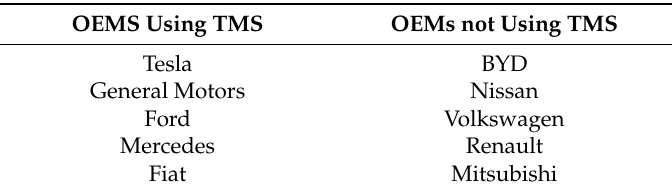
Table 6. List distinguishing OEMs who prefer to use a conventional thermal management system for their EV battery packs from those who do not rely on